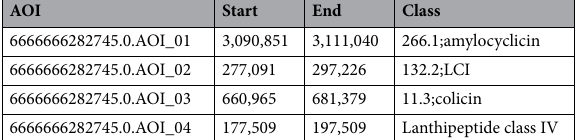
Table 2. Areas of interest (consolidated): results for ADS024 via BAGEL4 analysis. AOI area of interest, LCI low CO 2 (gene